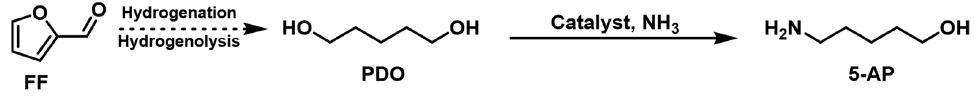
Figure 10. Hydrogen-borrowing amination of PDO and NH 3 to synthesize 5-AP.